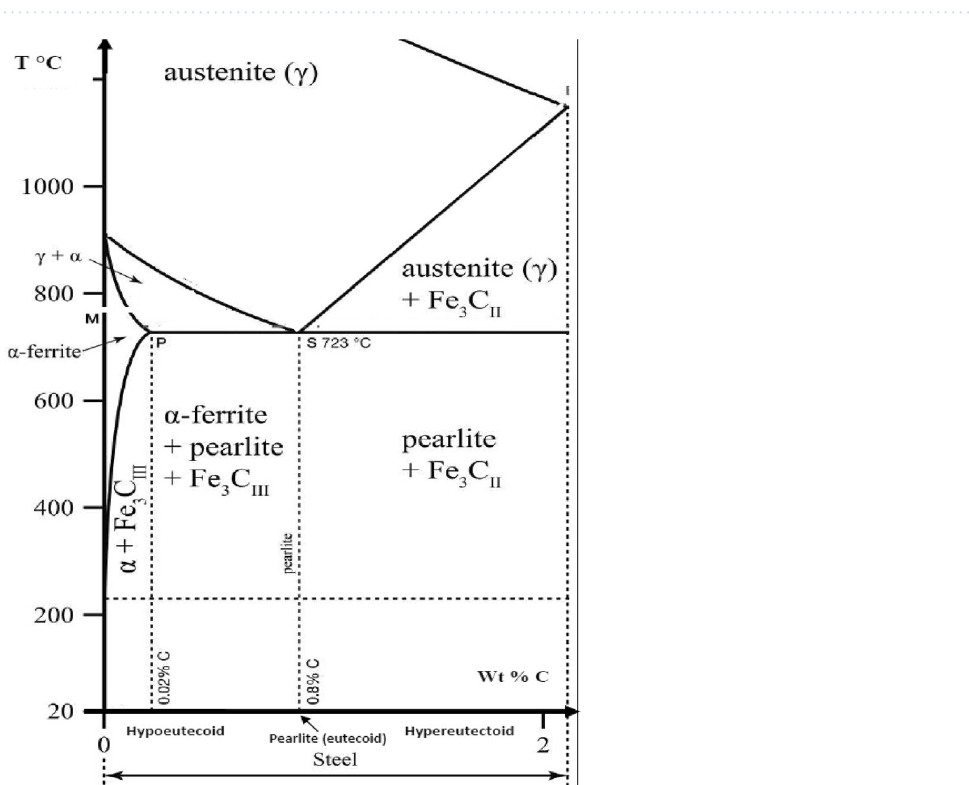
Figure 1. ( a ) Geometry form of the steel 316L before the welding. ( b ) microstructure of the steel 316L before the welding “magnified 300 times”.